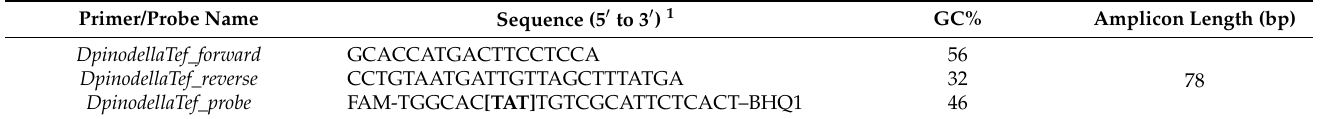
Table 2. Nucleotide sequences of DpinodellaTef primer and probe set used in the qPCR